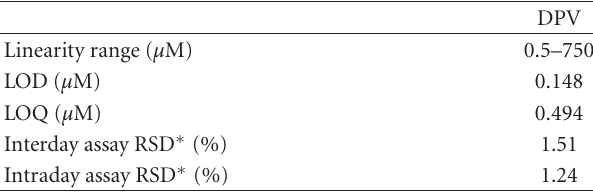
Table 1: Characteristics of calibration plot of MMF.